Question: In one sentence, what is this figure communicating?
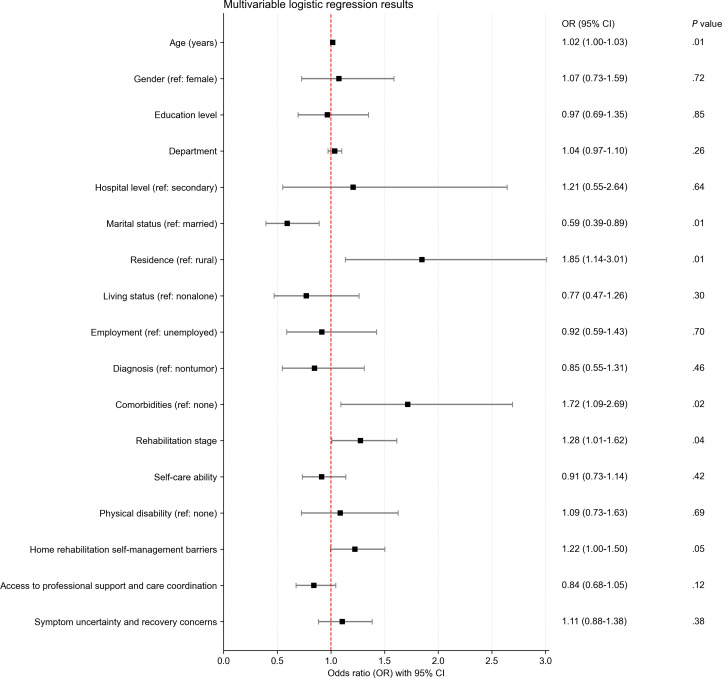
Answer: Forest plot of adjusted odds ratios for factors associated with the willingness to use AI-supported functions (N=752). “Residence” refers to nonrural (urban) vs rural; “marital status” refers to married vs unmarried or divorced or widowed; “comorbidities” refers to presence vs absence.